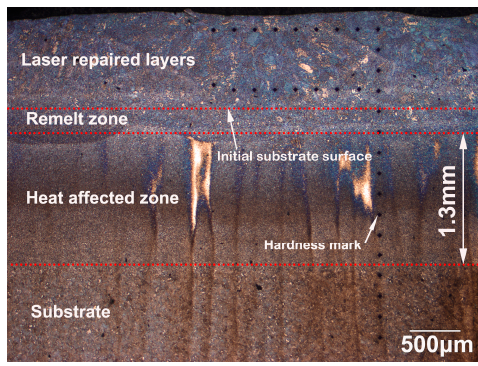
Figure 3. The cross-section of the top region in the five-layer laser forming repair (LFR) sample.